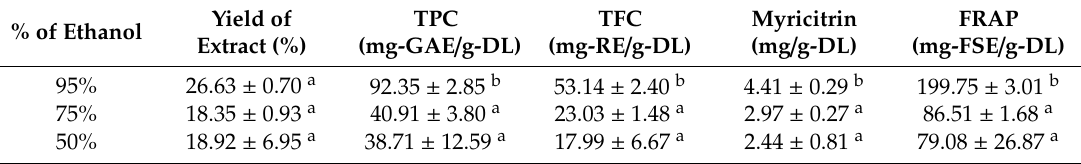
Table 1. E ff ects of % aqueous ethanol on yield of extract, TPC, TFC, myricitrin, and ferric reducing antioxidant power (FRAP) by UAE-40.